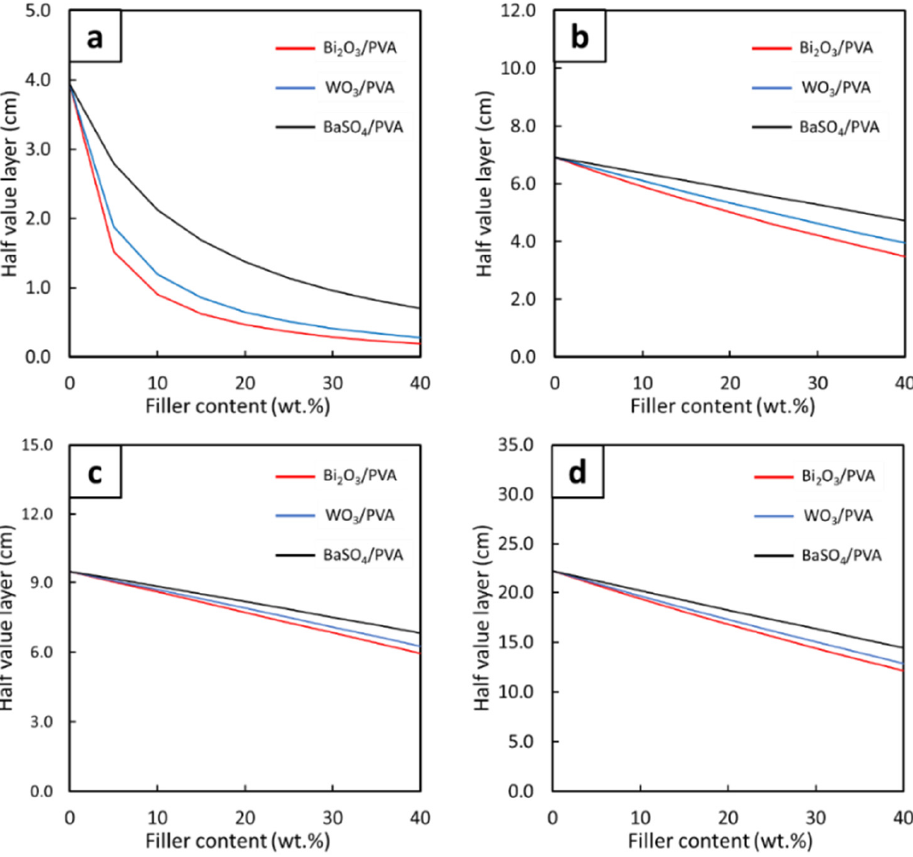
Figure 8. The HVL values of Bi 2 O 3 /PVA, WO 3 /PVA, and BaSO 4 /PVA hydrogels containing varying filler contents of 0–40 wt.%, determined at photon energies of ( a ) 0.1 MeV, ( b ) 0.5 MeV, ( c ) 1 MeV, and ( d ) 5 MeV using XCOM. Table 6. Mathematical constants (A, B, C, D, and F) for HVL in the form HVL = A x 5 + B x 4 + C x 3 + D x 2 + E x + F (Equation (7)), determined from Figure